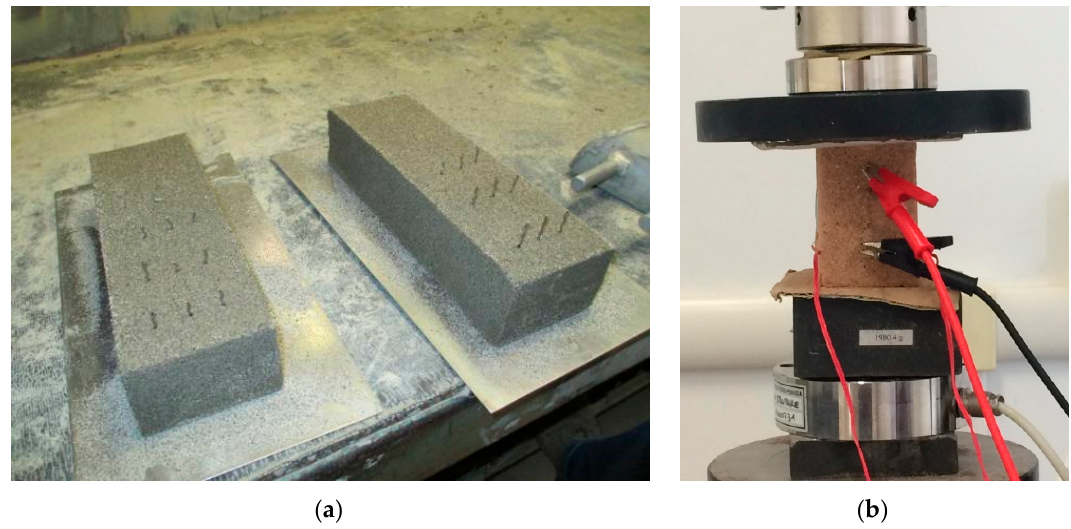
Figure 2. Smart bricks: ( a ) Preparation of smart bricks doped with conductive inclusions; ( b ) A smart brick after burning being tested in the